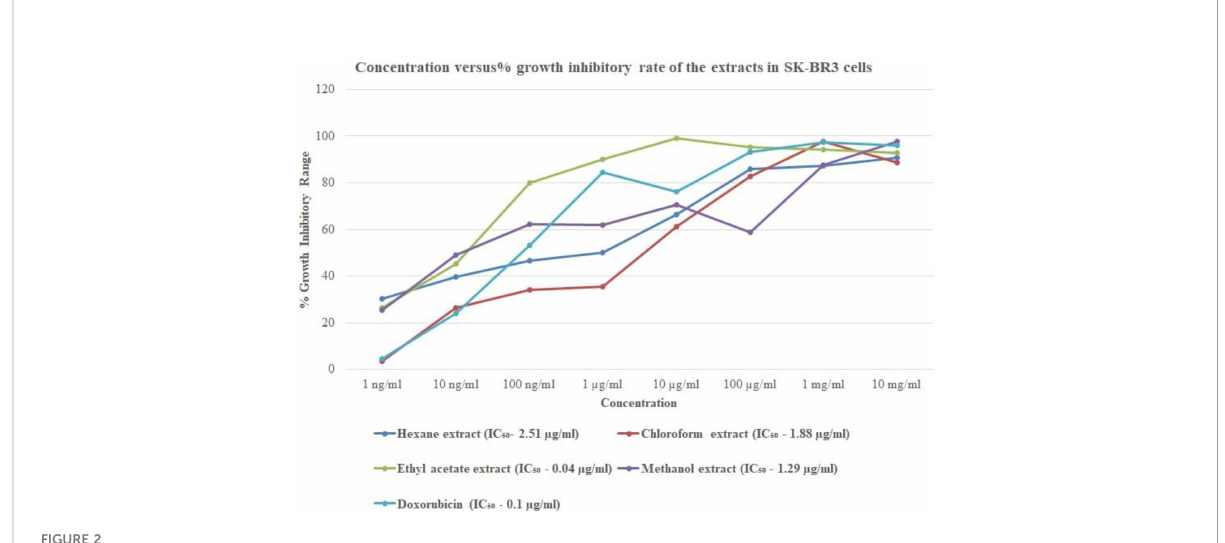
FIGURE 2 Concentration versus % growth inhibitory rate of the extracts in SK-BR3